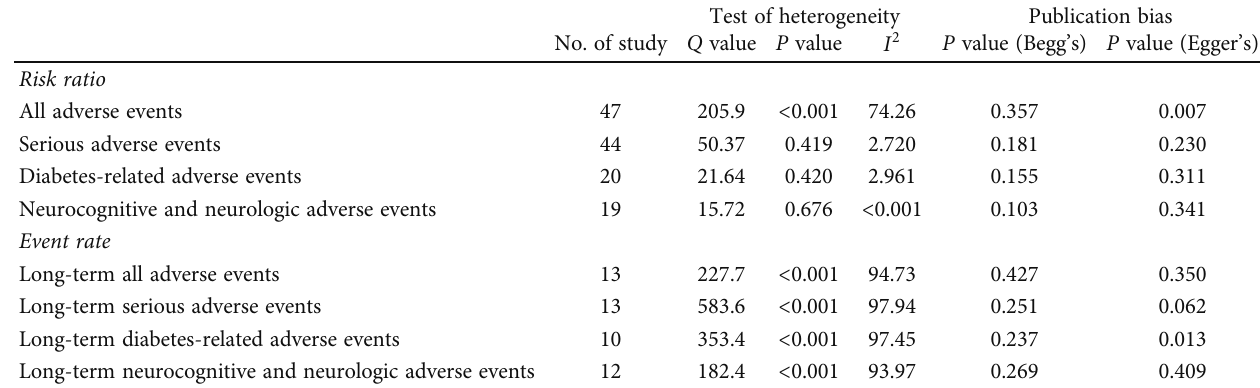
Table 2: Test of heterogeneity and publication